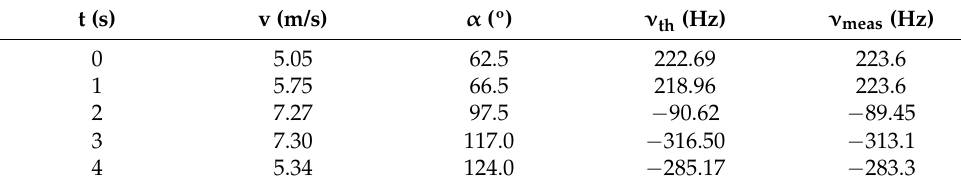
Figure 19. Evolution of the Doppler spectrum of the main delay component. Table 4. Comparison between measured and computed Doppler